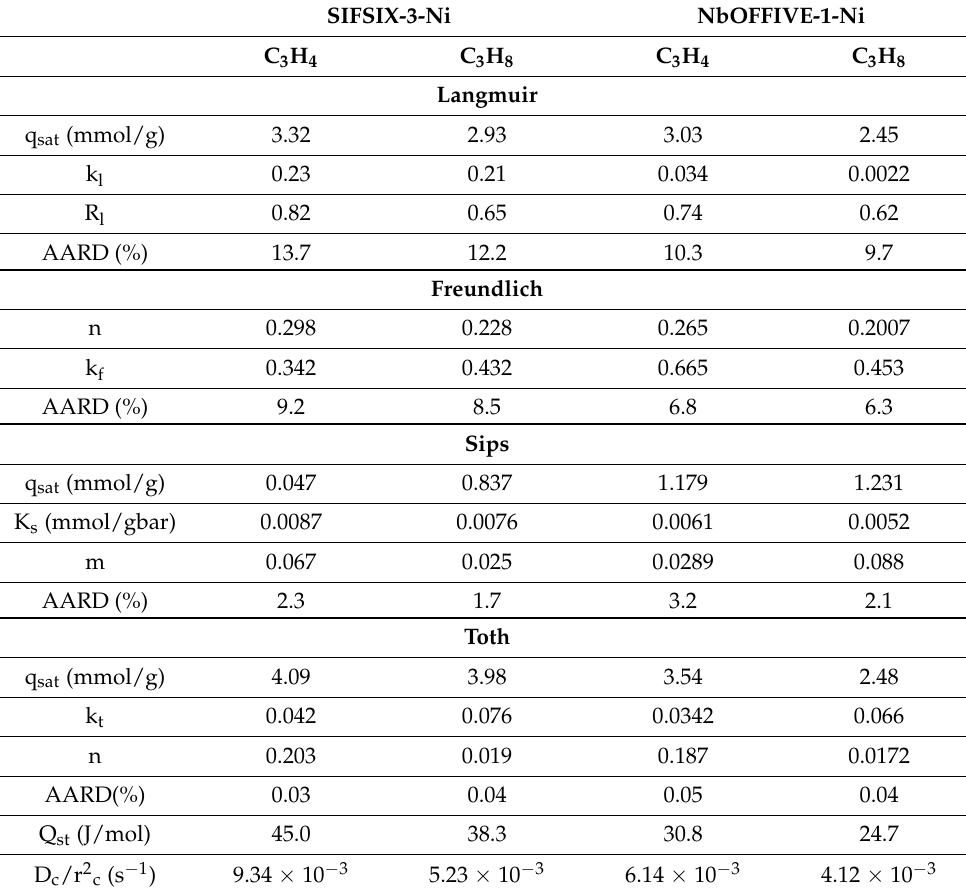
Table 3. Modeling isotherm statistical parameters, isosteric heats of adsorption and micropores diffusion time constants for MOFs and C 3 H 4 / C 3 H 6 at 300